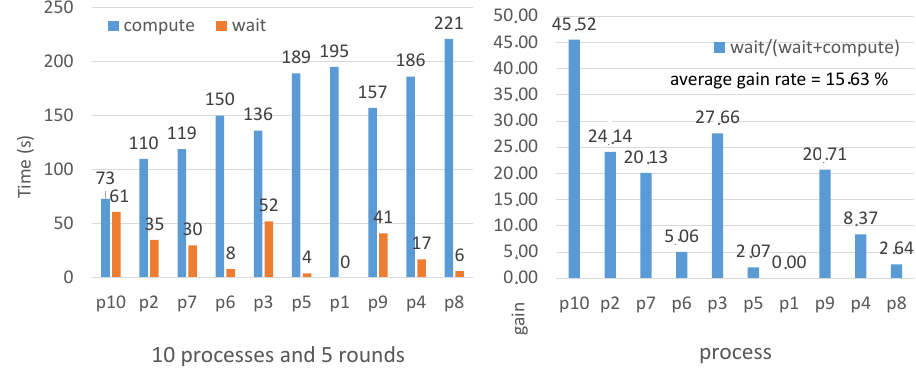
Figure 2. Compute and wait example